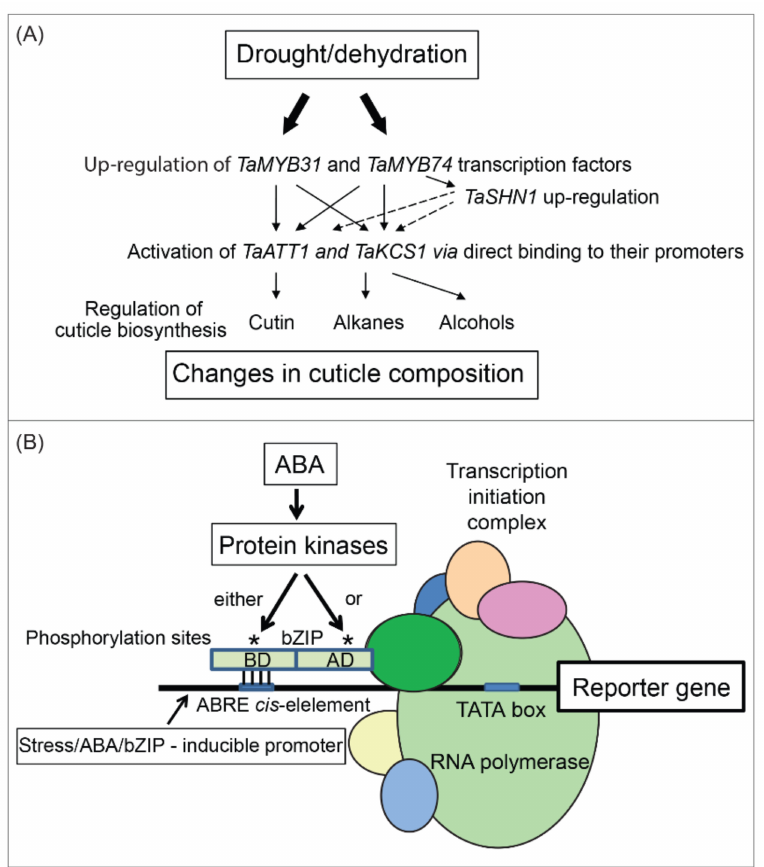
Figure 2. Regulatory mechanisms of wheat stress-responsive genes involved in drought and related stresses. ( A ) The proposed roles of wheat ( Triticum aestivum L.) TaWXPL1D and TaWXPL2B, and TaMYB31 and TaMYB74 TFs in the regulation of cuticle biosynthesis during a wheat response to drought stress (modified from [26,27]). ( B ) Schematics of the likely mechanism of activation of bZIP TFs through post-translational modifications. This experimental design based on [84,85] is explained in the